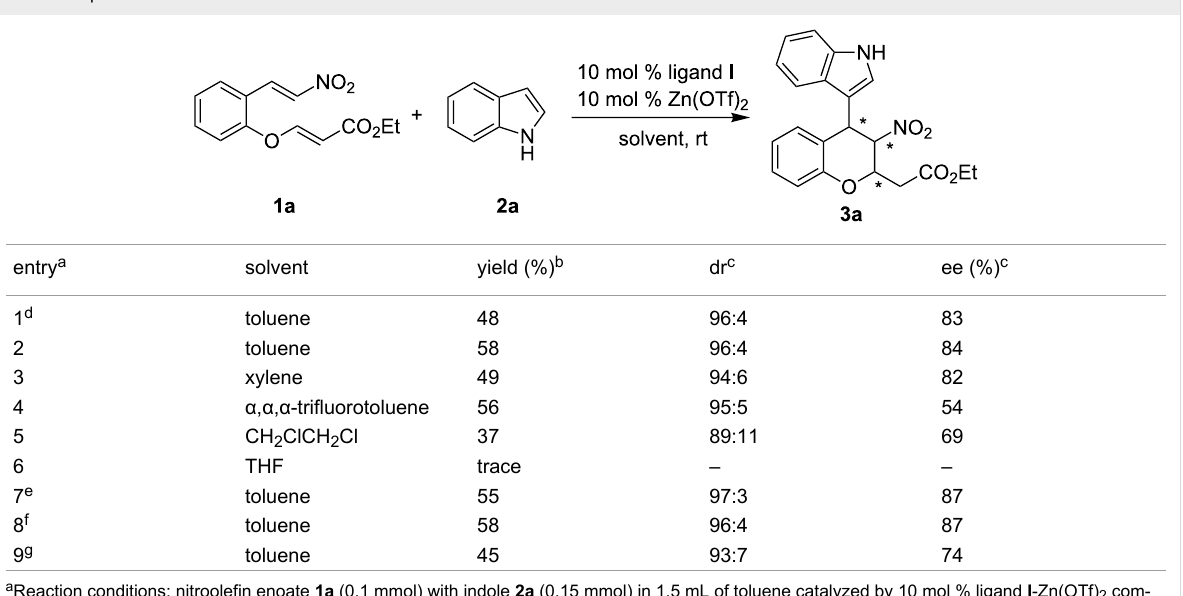
Table 2: Optimization of reaction conditions.